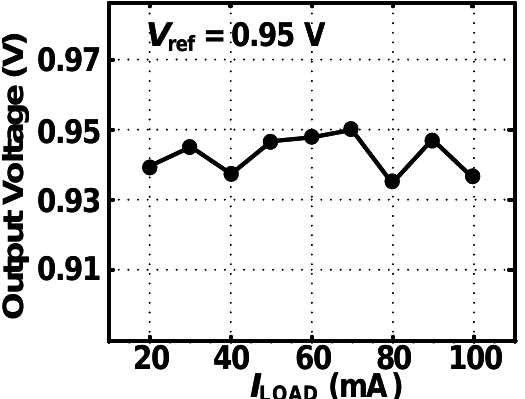
Figure 11. The output voltage under the variations of load